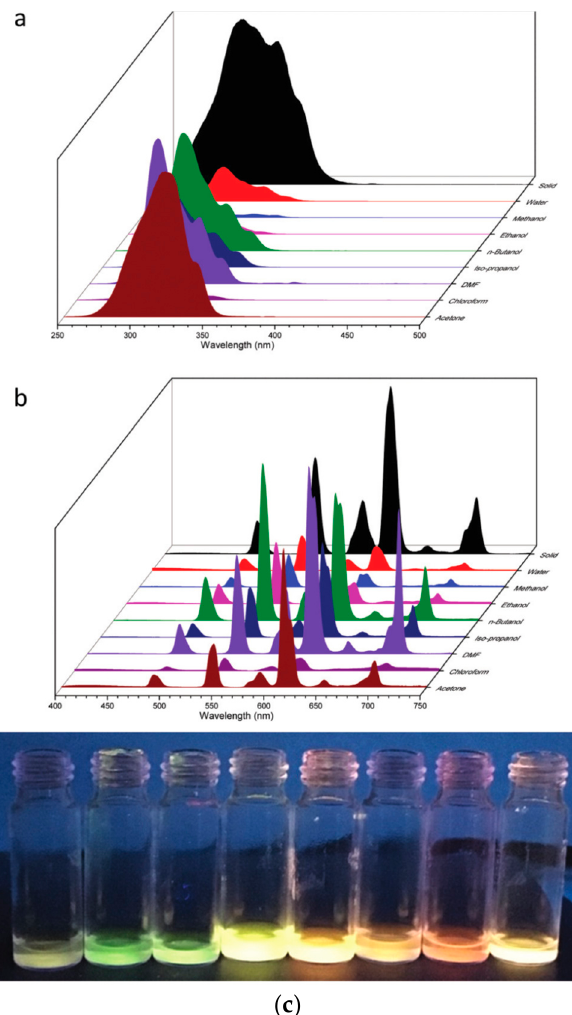
Figure 10. ( a ) Excitation spectra and ( b ) emission spectra of the DPA-‘PMO’ grafted with Eu,Tb and 1,10-phenanotroline in solid state and dispersed in different solvents. ( c ) Photo taken under a UV lamp (302 nm excitation) of the ‘PMO’ hybrid material in the different solvents (from left to right: water, methanol, ethanol, n-butanol, iso-propanol, DMF, chloroform and acetone) [59].